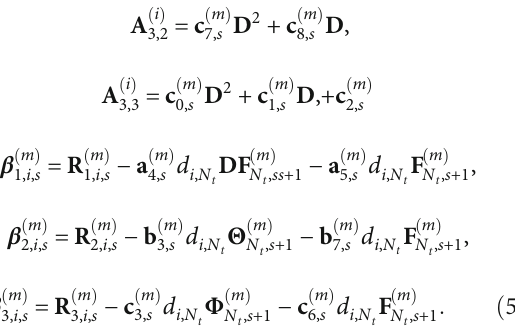
Figure 17: Concentration pro fi le for di ff erent values of Sc when λ = 0 : 1, N = 0 : 5, n = 0 : 5, f = δ = NR = 0 : 2, Sc = 0 : 6, and Pr = 1